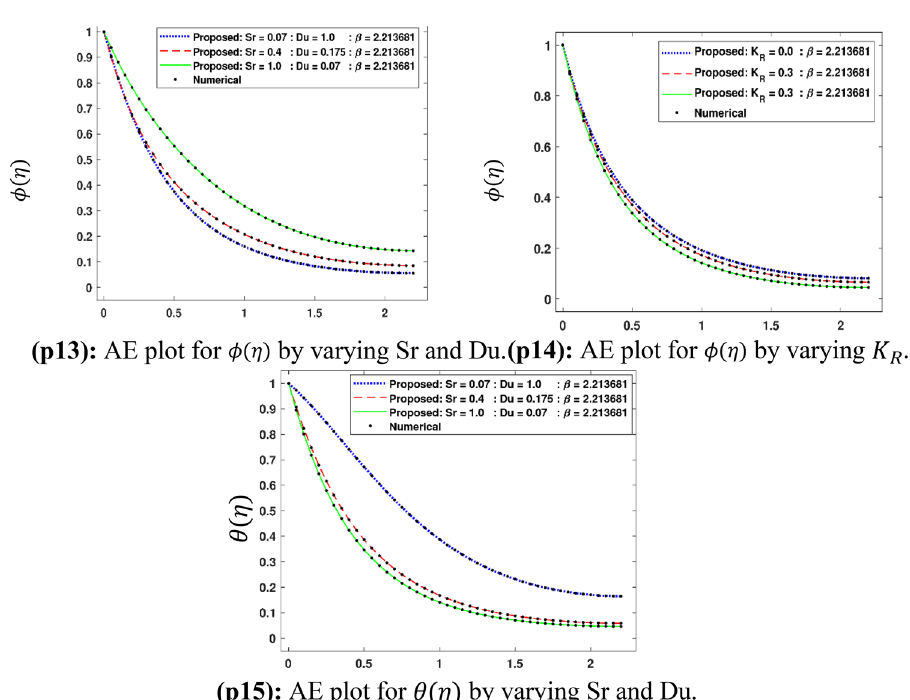
Figure 16. Solution plots of θ(η) and φ(η) by using the proposed